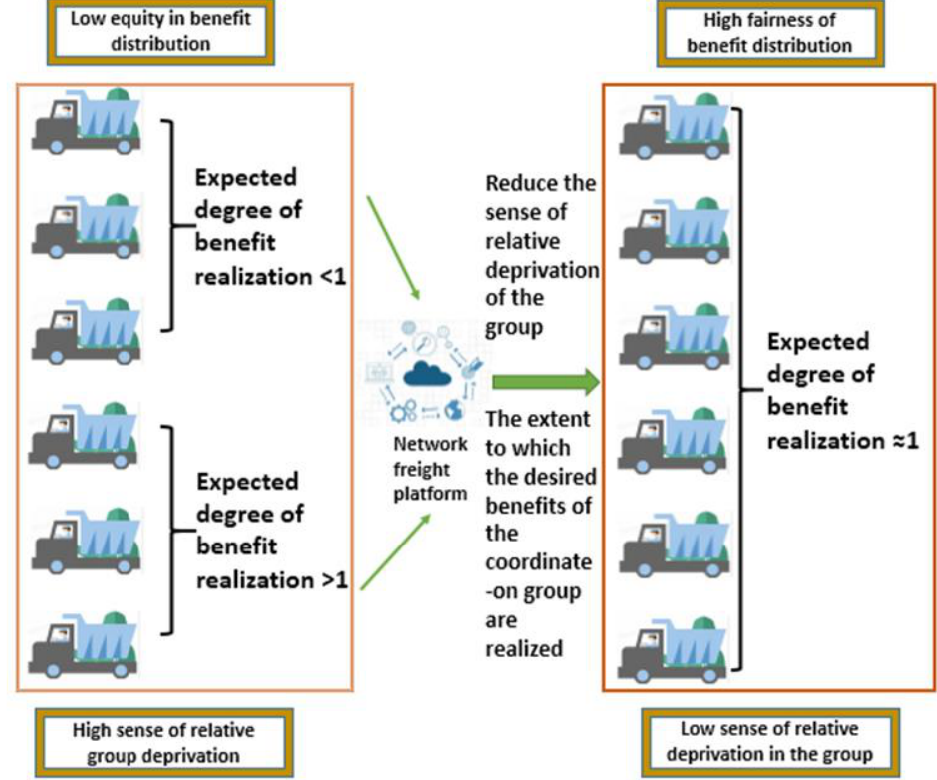
Figure 1. Network freight carrier driver benefit redistribution scenario.